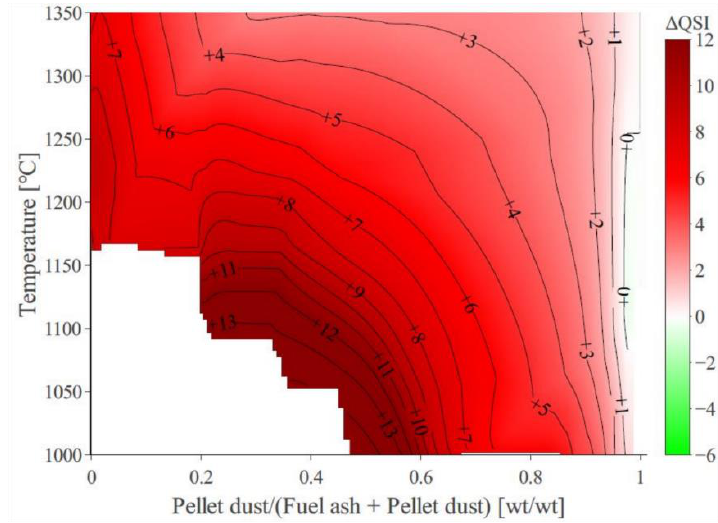
Figure 6. Plot of Δ(QSI) comparing the slagging tendency [g/kg ash input] of coal and raw stem wood Figure 6. Plot of ∆ (QSI) comparing the slagging tendency [g / kg ash input] of coal and raw stem wood when mixed with pellet dust. Δ(QSI) = (QSI) stem wood − (QSI) coal . Contours indicate Δ(QSI). when mixed with pellet dust. ∆ (QSI) = (QSI) stem wood − (QSI) coal . Contours indicate ∆